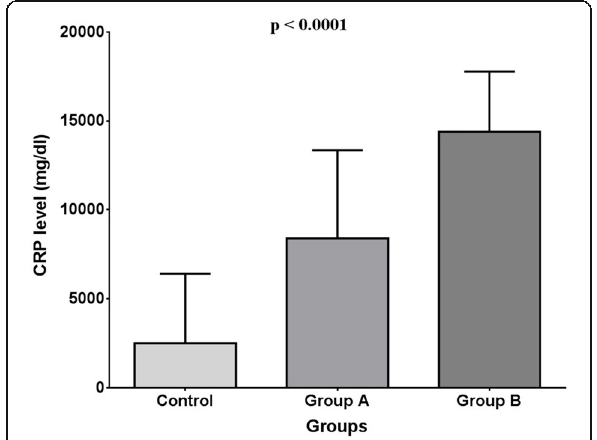
Fig. 2 One-way ANOVA test for CRP